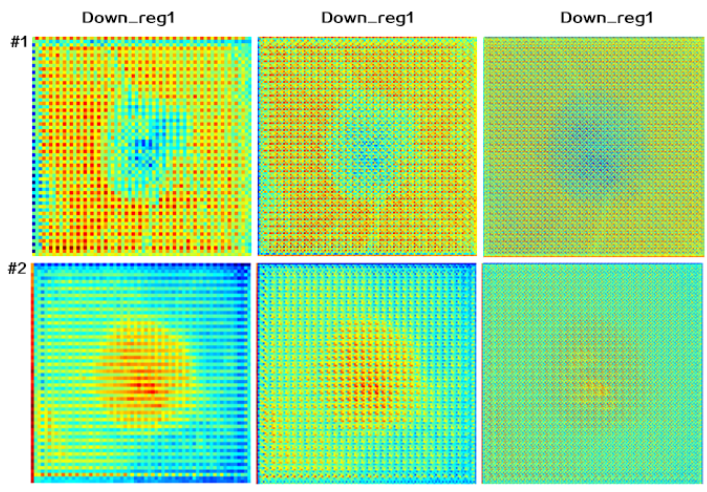
Figure 7. Examples of special circumstances. First row: the CDR obtained by regression is from the background region, second row: the CDR obtained by regression is from the OD and OC region. Here the “down_reg i” represents the i th down-sampling